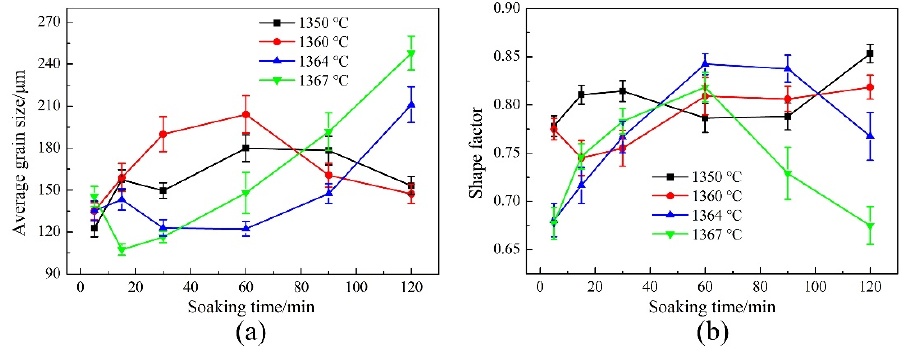
Figure 7. Variations of ( a ) average grain size and ( b ) shape factor of GH3536 alloy heat treated with different parameters.